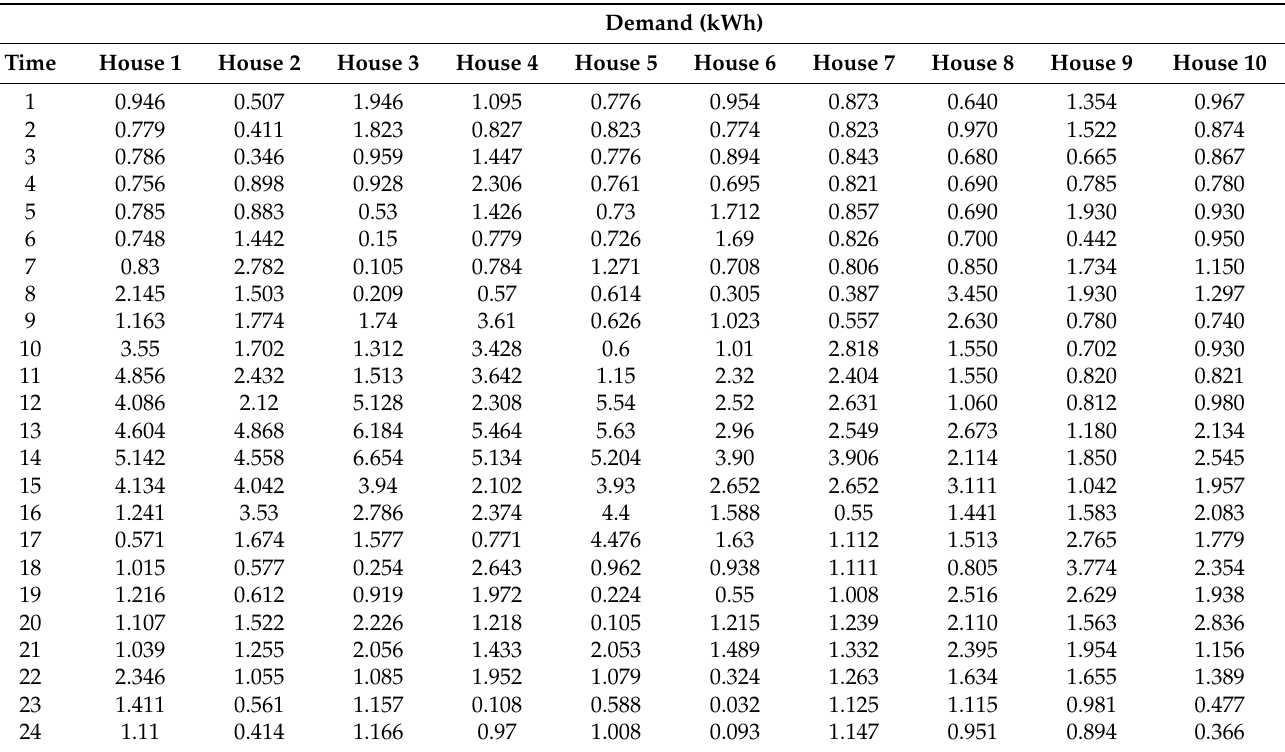
Table A1. An Example of Smart Data for Ten Householders for a Working